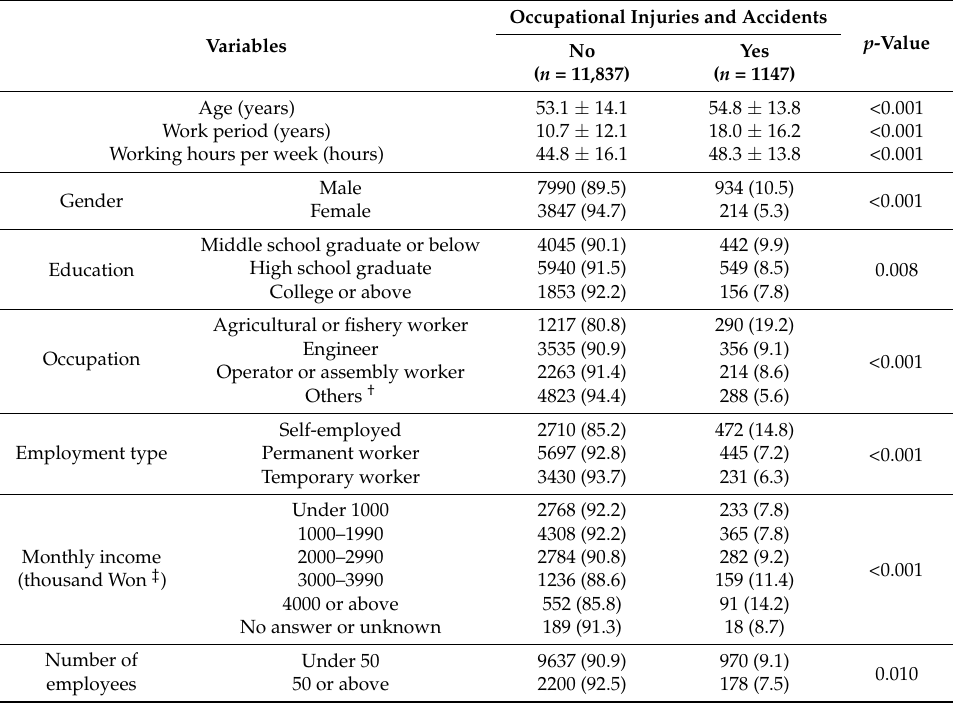
Table 1. General characteristics of the study subjects.